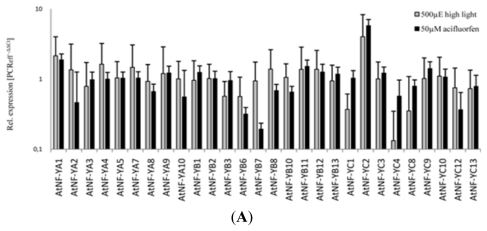
(A) Transcript profiles of AtNF-Y genes after acifluorfen treatment and high light exposure. Three-week-old A. thaliana (Col-0) seedlings were exposed to either 3 h of 500 μmol photon m−2·s−1 or treated with 50 μM acifluorfen for 3 h. The transcript levels were normalized to a member of the SAND gene family (At2g28390). RNA levels were assayed by qRT-PCR in comparison to those of control seedlings. Representatives of the 36 Arabidopsis NF-Y genes not listed in the graph were not detectable in seedlings. Only the AtNF-YC2 transcript strongly accumulates after high light exposure and acifluorfen treatment; (B) AtNF-YC2 transcript levels after exposure to various stress conditions and after treatment with herbicides. The NF-YC2 RNA contents were compared in stress-exposed and control seedlings after normalization to transcript levels of the SAND gene. The different stress conditions and applications are described in Material and Methods. AtNF-YC2 shows a strong accumulation of RNA in response to several adverse conditions; (C) Phylogenetic tree of selected NF-YC proteins. Full-length amino acid sequences of Arabidopsis NF-YC proteins and HAP5b (NtNF-YC) of Nicotiana tabacum were used for alignment (using MUSCLE 3.7 and Gblocks 0.91b), phylogenetic analysis (PhyML3.0 aLRT) and tree rendering (TreeDyn 198.3) performed with the phylogeny resource www.phylogeny.fr. [25].